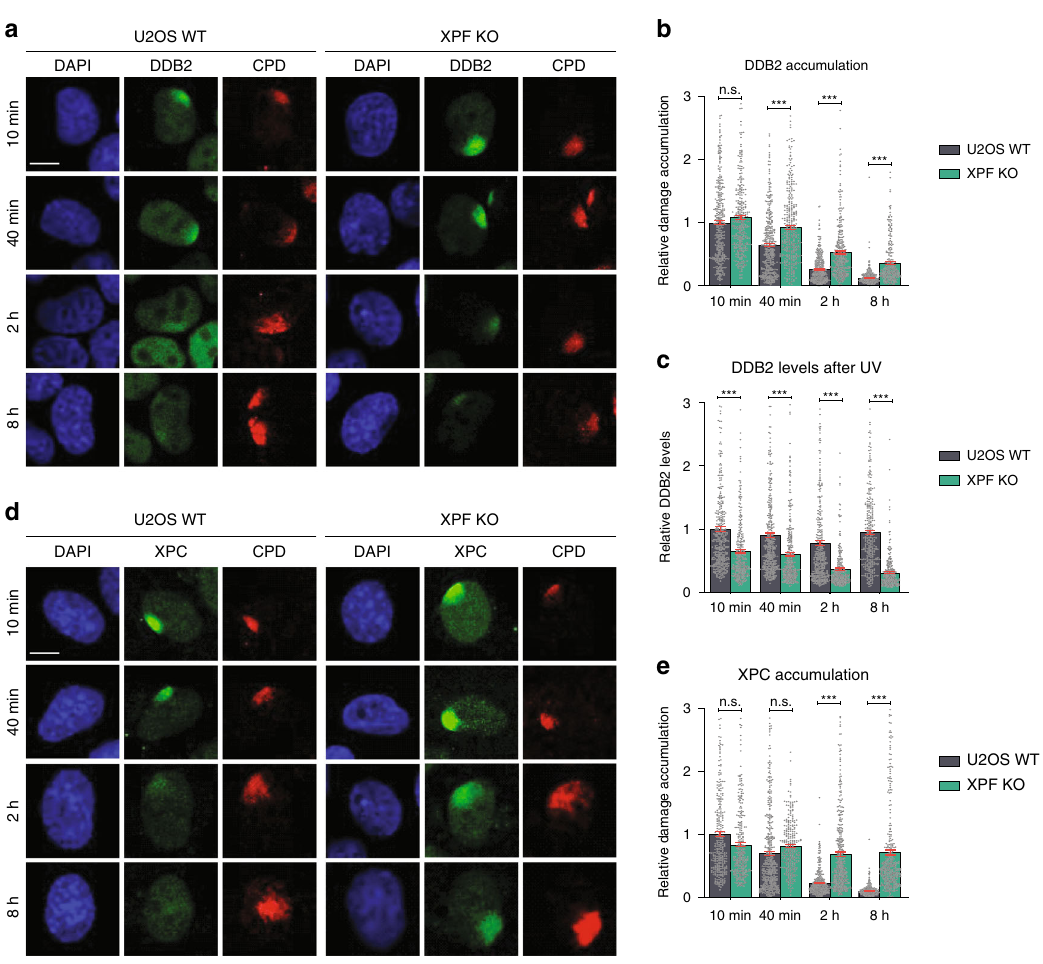
Fig. 2 Persistent damage detection in absence of lesion excision. a Representative immuno fl uorescence (IF) images of endogenous DDB2 accumulation at local UV-C damage (LUD) in U2OS wild-type (WT) and U2OS XPF knockout (XPF KO) cells. Cells were fi xed 10 min, 40 min, 2 h and 8 h after LUD (marked by CPD staining) induced with UV-C irradiation (60 J/m 2 ) through a microporous membrane (8 µ m). b Quanti fi cation of DDB2 accumulation at LUD, as depicted in ( a ). DDB2 accumulation was normalized to the nuclear background and U2OS WT 10 min after UV-C, which was set to 1.0. c Total DDB2 protein levels determined by measuring total nuclear fl uorescent signal intensities in nuclei such as depicted in a and normalized to U2OS WT 10 min, which was set to 1.0. d Representative IF images of endogenous XPC accumulation at LUD in U2OS WT and XPF KO cells, as described in ( a ). e Quanti fi cation of XPC accumulation at LUD, as depicted in ( d ) and described in ( b ). Mean and S.E.M. of, respectively, n = 348, 313, 383, 334, 355, 334, 316, 247 cells for DDB2 and n = 305, 276, 413, 272, 339, 383, 266, 339 cells for XPC from fi ve independent experiments. * P < 0.05, ** P < 0.01, *** P < 0.001, analyzed by one-way ANOVA (see “ Methods ” ). Scale bars in ( a , d ): 5 µ m. Source data are provided as a Source Data fi